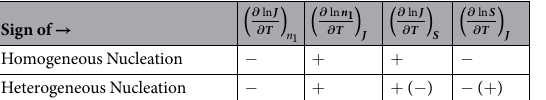
and n * , the Kelvin relation for r * , and the onset